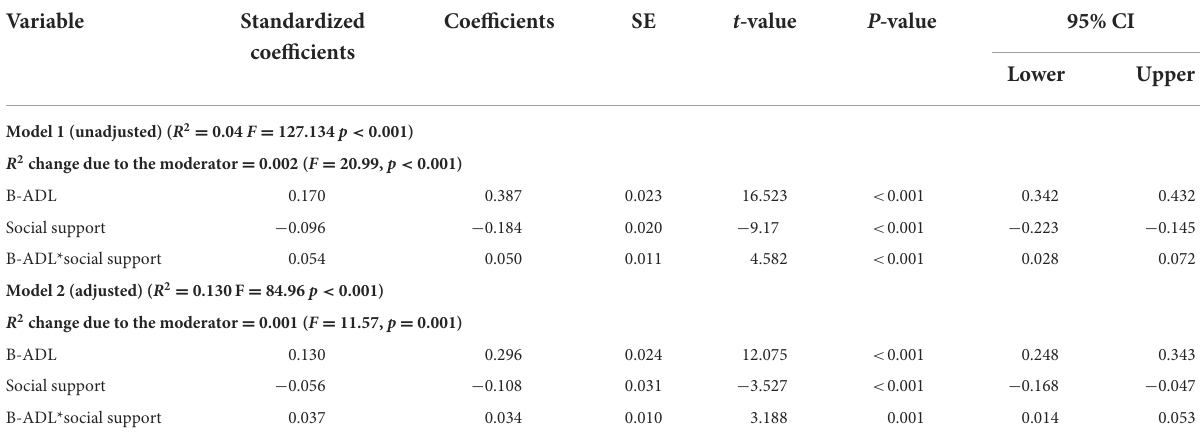
TABLE 2 Moderation analysis of social support for the association between B-ADL and depressive symptoms. Variable Standardized Coefficients SE t- value P- value 95% CI coefficients